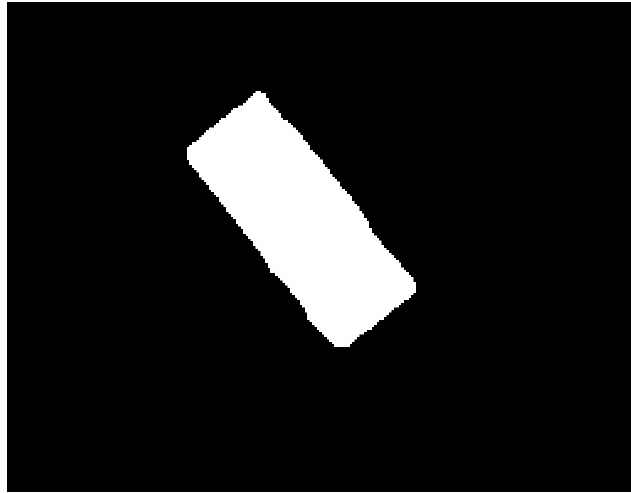
Figure 3. Result obtained after the processing in step 2.